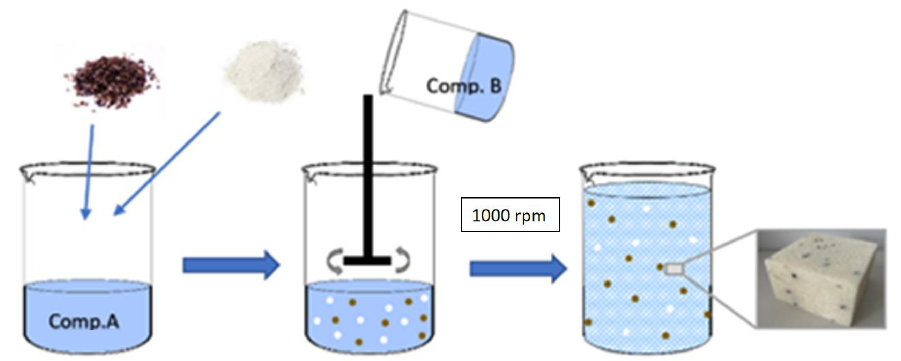
Figure 1. Method of preparing PU foams. Table 1. The flame retardants added to the foam during synthesis in parts by weight per 100 parts of